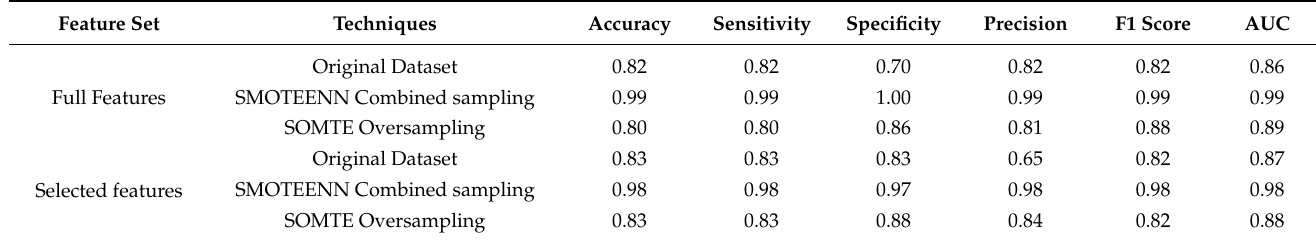
Table 1. Results of the proposed model for the diagnosis of thyroid cancer.